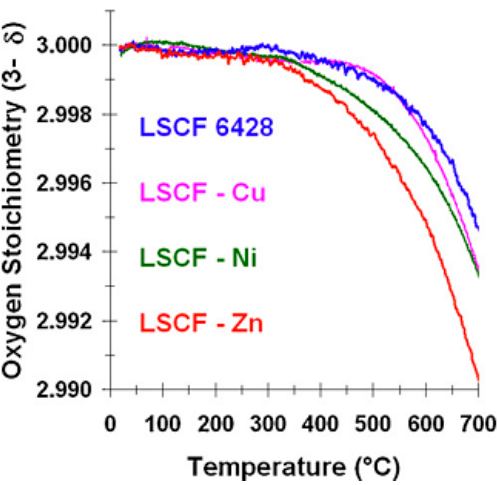
Figure 8. Oxygen vacancy generation of La 0.6 Sr 0.4 Co 0.18 Fe 0.72 X 0.1 )O 3 −δ (where X = Zn, Ni or